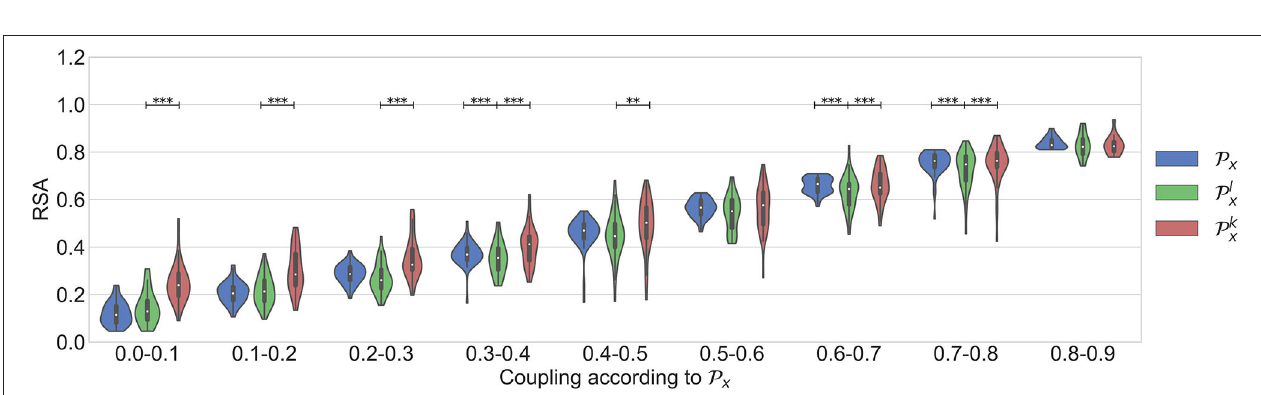
FIGURE 4 | Results using the dataset of clean segments, free of apneas, and with regular